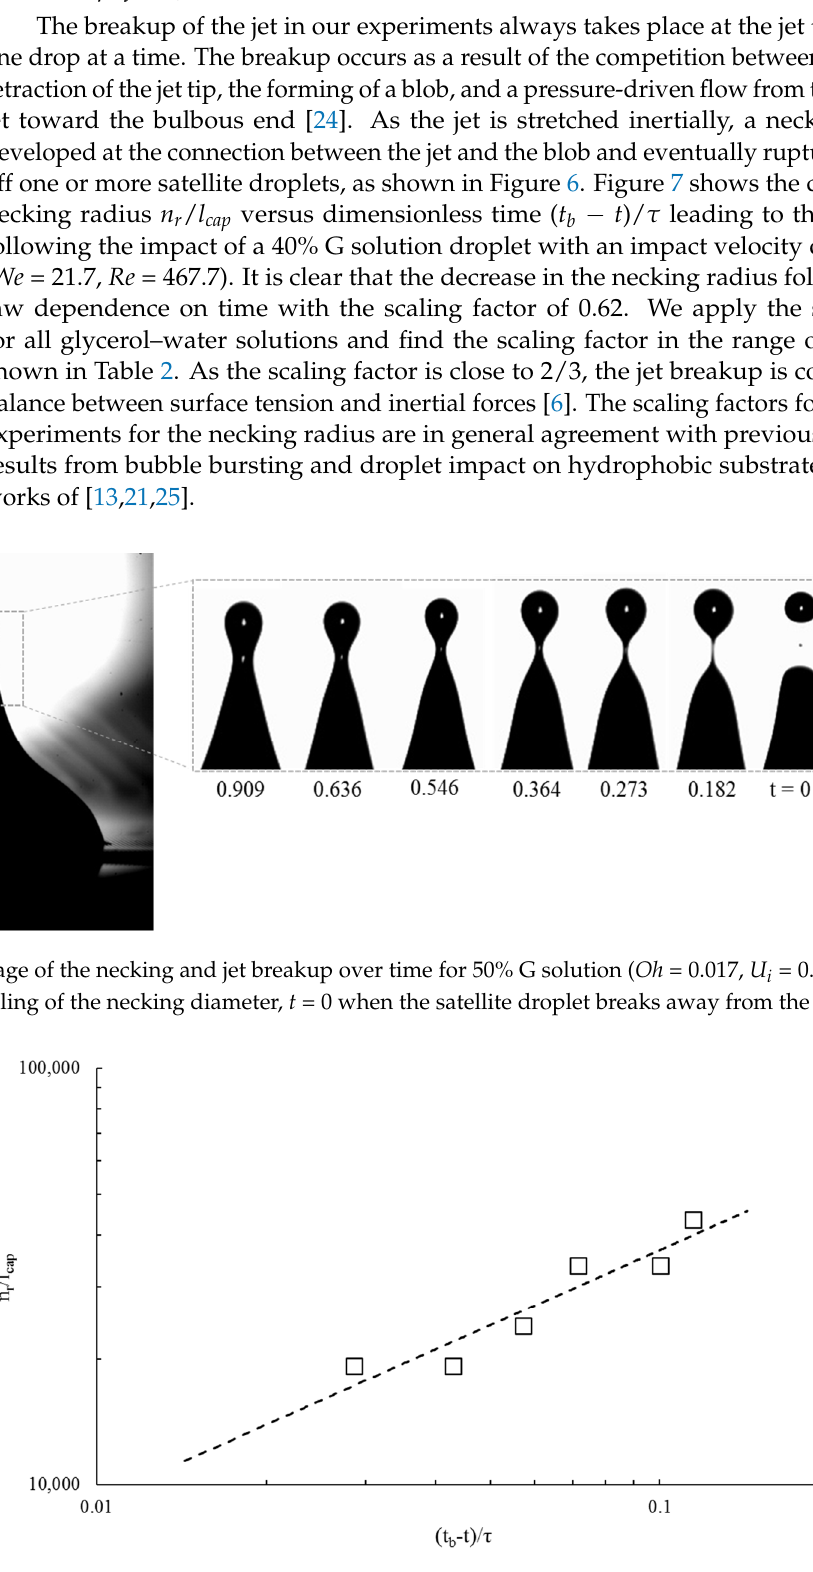
Figure 7. Log–log plot of dimensionless necking radius n r / l cap versus dimensionless time ( t b − t )/ τ for 50% G solution ( Oh = 0.017, U i = 0.7004 m/s, We = 22.6, Re = 280.2). The dashed line is the power law fit, n r / l cap ~(( t b − t )/ τ ) 0.60 .